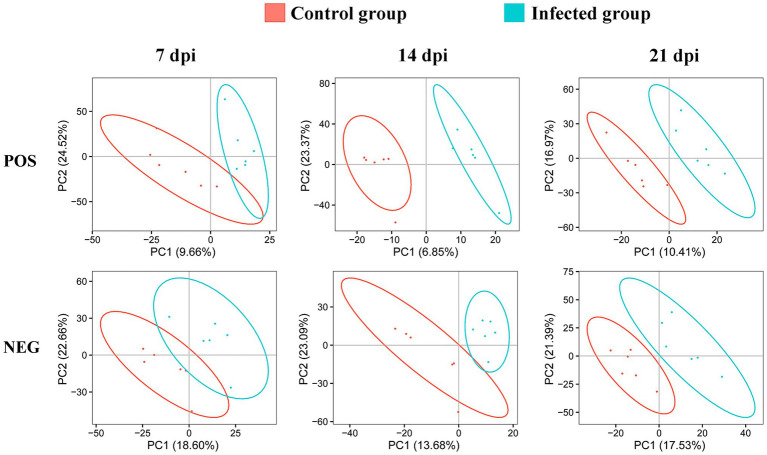
Two-dimensional partial least squares-discriminant analysis (PLS-DA) score plots of liquid chromatography-mass spectrometry metabolomic data showing the separation between infected and control mice at 7, 14, and 21 dpi in the positive (POS) and negative (NEG) ion modes. The ellipses enclose the 95% confidence intervals estimated by the sample means and covariances of each group.